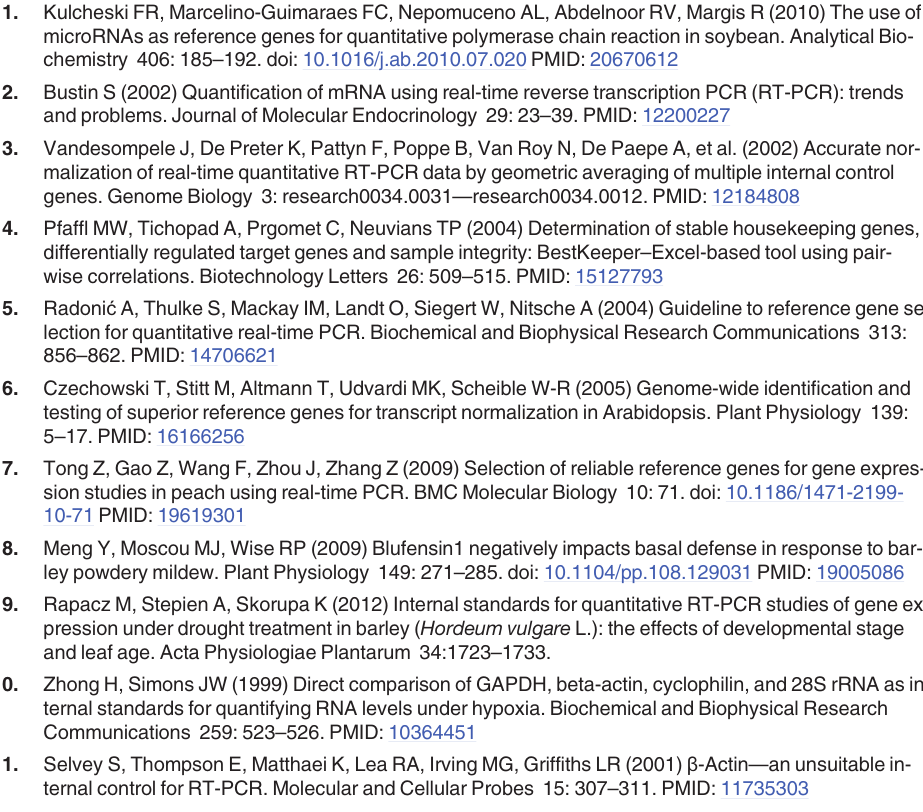
S5 Fig. Melt curve and standard curve of SUPEROXIDE DISMUTASE . (TIF) S6 Fig. Melt curve and standard curve of miR5048. (TIF) S1 Table. Primers used for sequencing individual candidate reference genes. S2 Table. Primers used for qPCR of barley Superoxide dismutase and